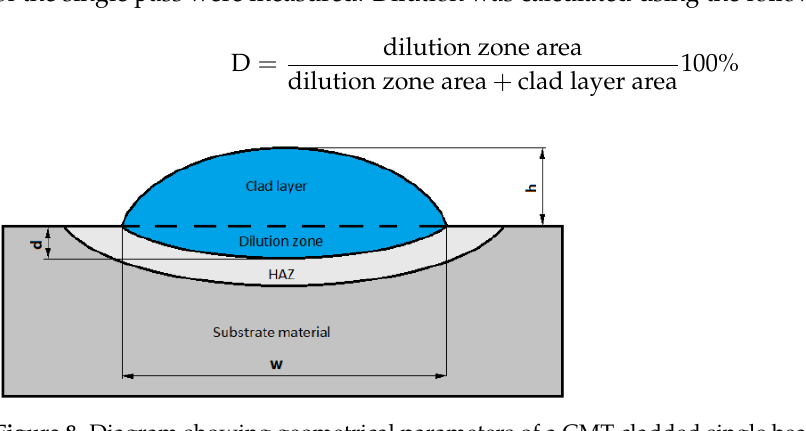
Figure 7. Macrostructure of STELLITE 6 coating cladded on 16Mo3 steel tube, average thickness 2.1 mm (×25).